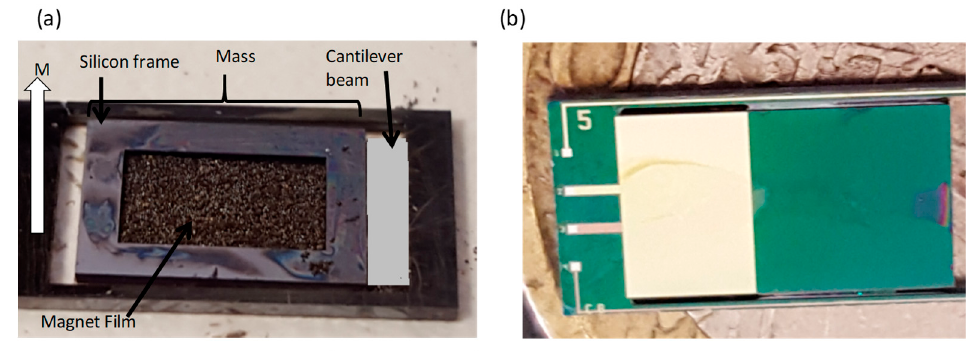
Figure 4. Image of fabricated device: ( a ) backside of the out-of-plane device with embedded magnetic material; ( b ) top view of the device with piezoelectric beam and large silicon mass. Scale bar is 5 mm.